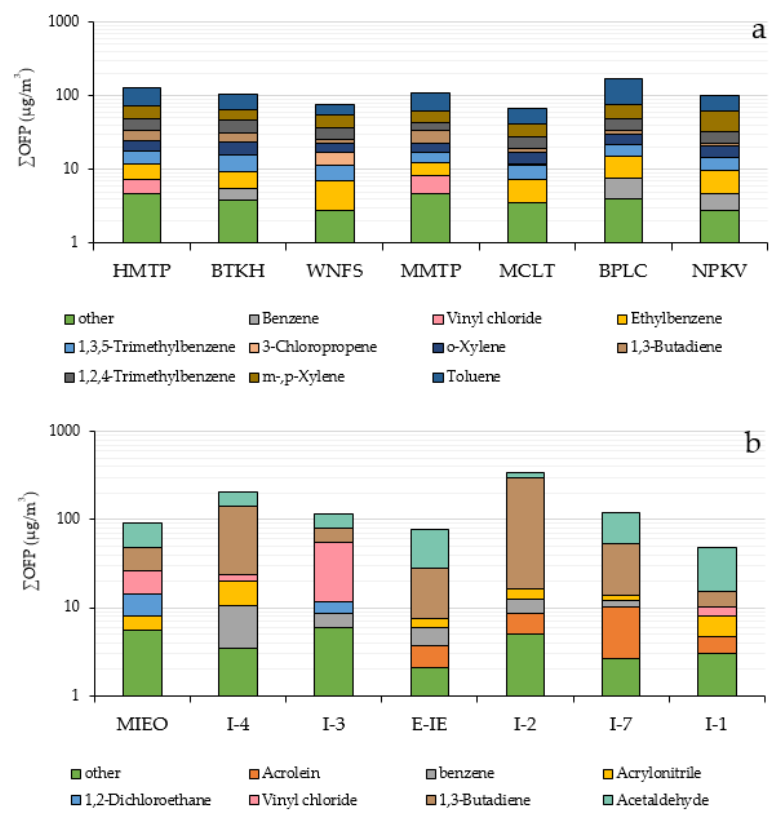
Figure 5. Ozone formation potential of ambient VOCs in each monitoring station in community areas ( a ) and within industrial areas ( b ). Table 3. Ozone formation potential in this study compared with other studies.